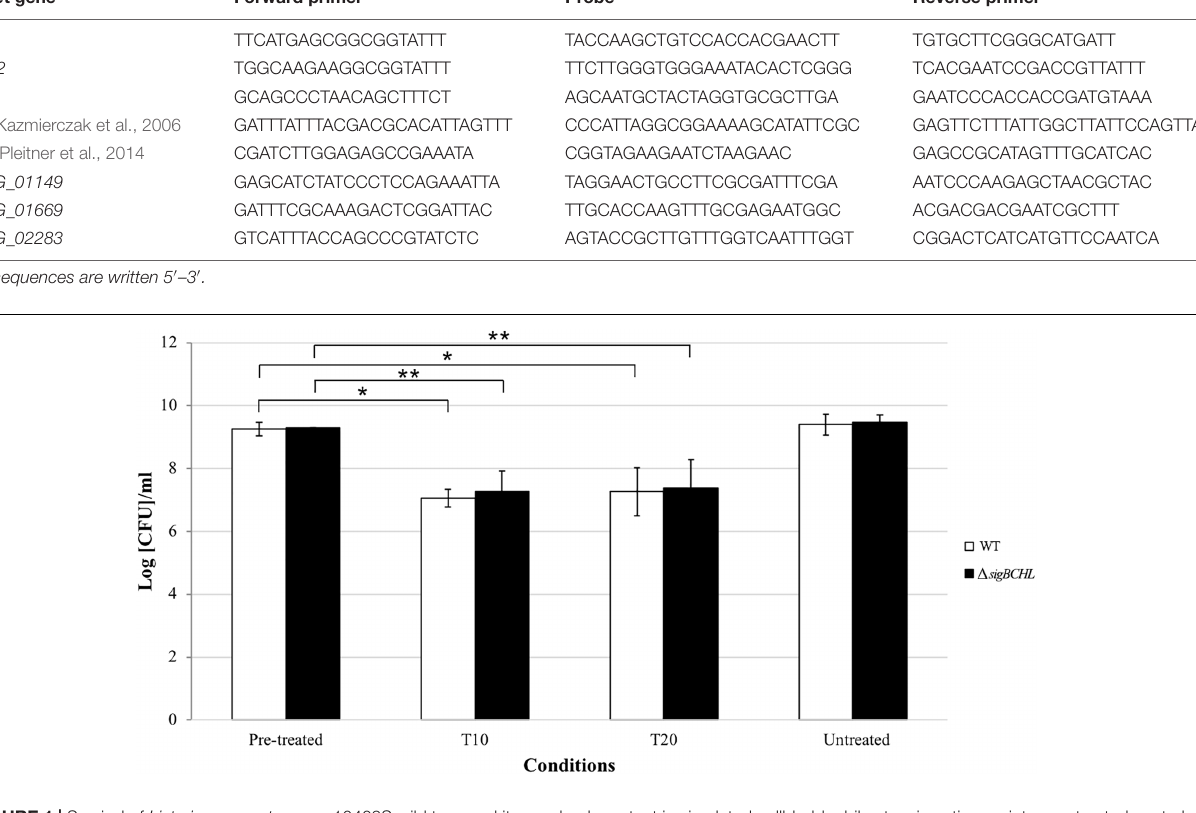
15s, and 55 ◦ C for 1 min. Transcripts were normalized by a geometric mean of housekeeping genes, rpoB and bglA . compared statistically using unpaired t -test, SPSS version 23 (IBM, United States). Statistical comparison of gene expression levels among L. monocytogenes strains in each condition were analyzed by unpaired t